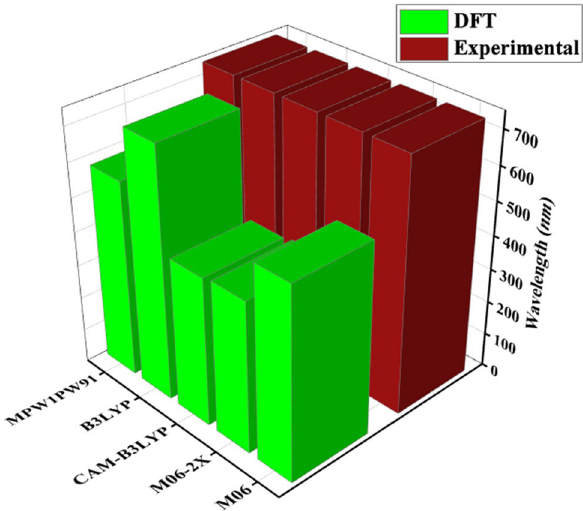
Figure 9. Comparison between DFT and experimental UV–visible results of MR1 at various levels in chloroform solvent. These graphs are drawn by utilizing Origin Pro 8.5 version (https:// origi npro. infor mer. com/8. 5/). All out put flies of entitled compounds were computed through Gaussian 09 version D.01 (https:// gauss ian. com/ g09ci